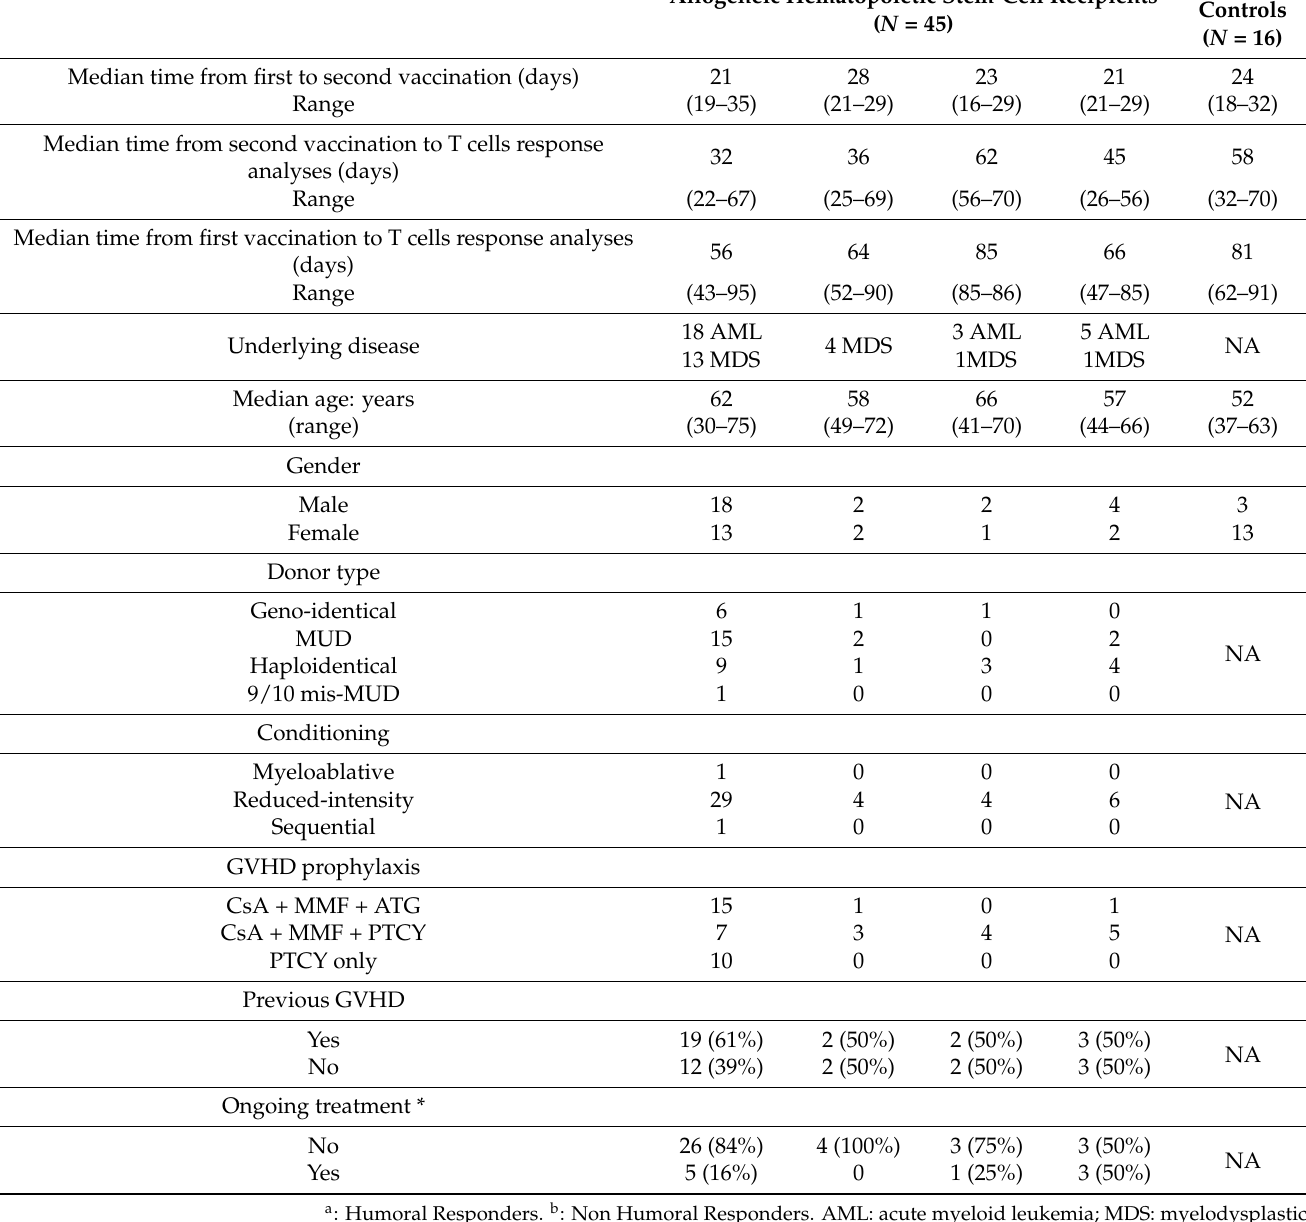
Allogeneic Hematopoietic Stem-Cell